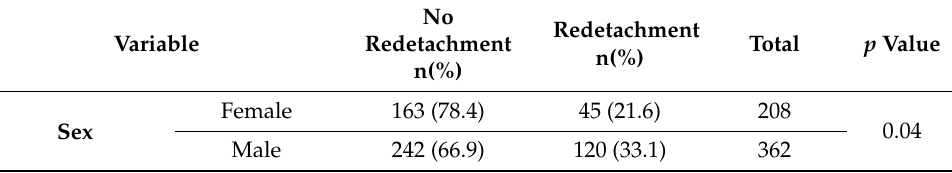
Table 5. Univariate analysis of the variables used for retinal redetachment analysis. Univariate analysis of qualitative variables that might be associated with retinal redetachment was performed using chi-square tests. The number and percentage of cases of no redetachment and redetachment within each variable are indicated, as are the total numbers for each variable. Chi-square p -values are shown, considering p < 0.05 to be statistically